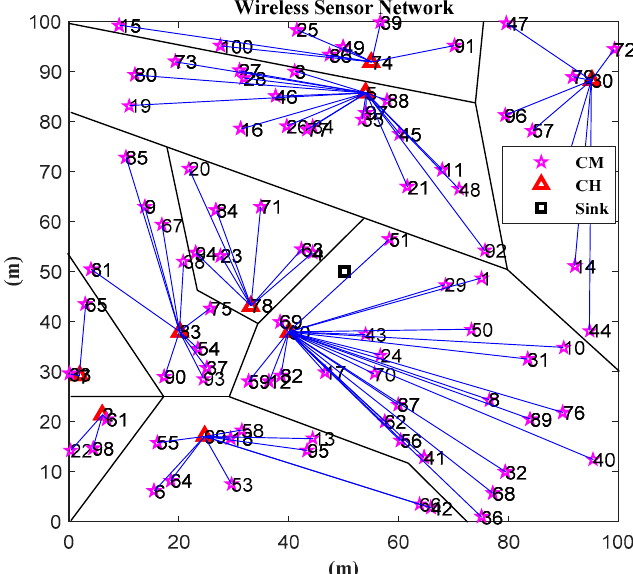
Figure 9. WSN topology and ICL-LEACH-CS algorithm clustering process.